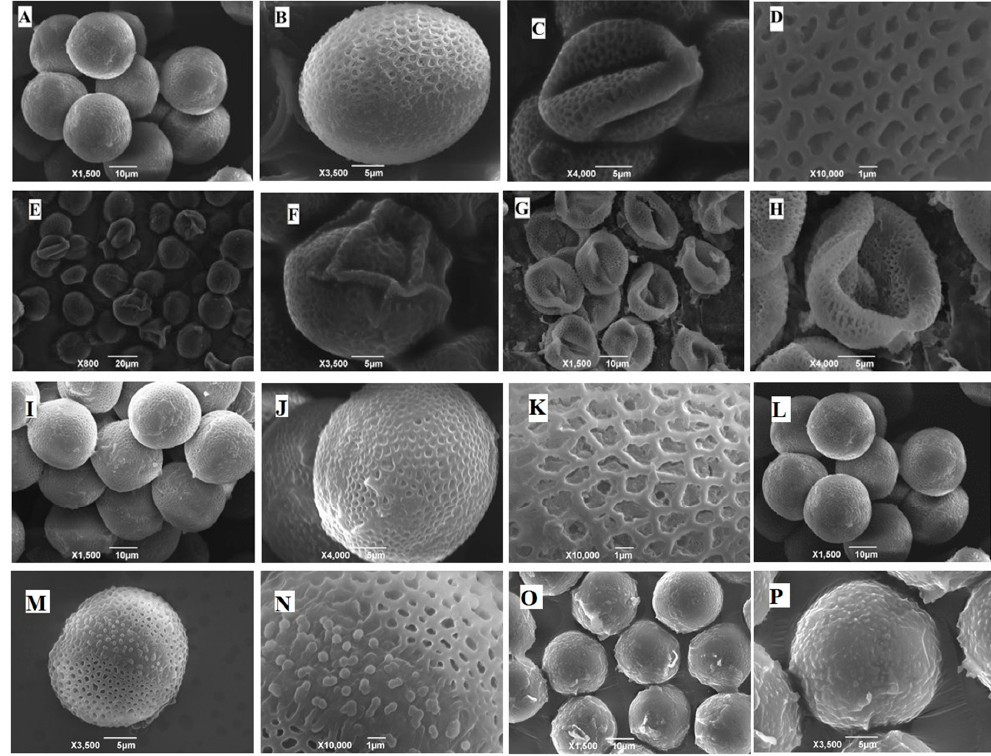
Figure 6. Scanning electron micrographs of B. napus ’ pollen grains. Control ( A – D ), plants treated with Cd ( E – H ), Cd + Se ( I – K ), Cd +Mo ( L – N ), and Cd + Se + Mo ( O , P ). Plants were treated with foliar spray of Se (1 mg/L) and/or Mo (0.3 mg/L) in absence or presence of Cd stress (5